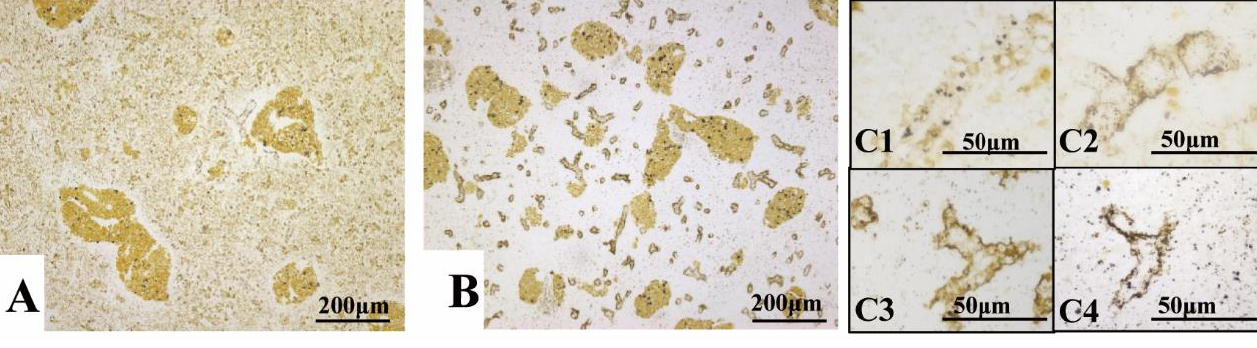
Figure 5. The dynamic monitoring of Trypan blue and ACP (Acid phosphatase) post vital staining. ( A ). 1 hpi ( i.v. ), Trypan blue scattered in the parenchyma and few of them deposited around the ellipsoids; ( B ). 3 hpi ( i.v. ), most of the Trypan blue deposited around the ellipsoids and few appeared in the parenchyma; ( C1 – C4 ) : Dynamic changes of Trypan blue deposited around the ellipsoids from 1 – 24 hpi ( i.v. ), respectively, ( C1 ):1 hpi, ( C2 ): 2 hpi, ( C3 ): 3 hpi and ( C4 ): 24 hpi; ( D ): Control spleen without any Trypan blue; ( E ). 8 hpi ( i.p. ), Trypan blue aggregated in the ellipsoids; ( F1 – F4 ): Dynamic changes of Trypan blue in the ellipsoids from 4 – 72 hpi ( i.p. ), respectively, ( F1 ): 4 hpi, ( F2 ): 8 hpi, ( F3 ): 24 hpi, ( F4 ): 72 hpi; ( G ). Normal spleen present little ACP in the endotheliocytes of EC; ( H ). 8 hpi ( i.p. ), ACP appeared in the endotheliocytes of EC and cells of the splenic cords; ( I1 – I4 ): Dynamic changes of the ACP ( → ) from 4 – 72 hpi( i.p. ), respectively, ( I1 ): 4 hpi, ( I2 ): 8 hpi, ( I3 ): 24 hpi, ( I4 ): 72 hpi; Staining method: ( A – F ), paraffin sections without staining; ( G – I ): frozen sections with Gomori staining. In contrast, Trypan blue was engulfed by the endotheliocytes of ECs post intraperi- toneal injection. No particles were observed in the capsule and fibers (Figure 6A). The particles were first observed at 4 hpi, whereafter the area and IOD increased significantly to a summit at 8 hpi. A remarkable decrease of the area and IOD were found at 24 hpi. At 72 hpi, the area and IOD of Trypan blue showed no markable difference to the control group (Figure 5D – F and Figure 6).